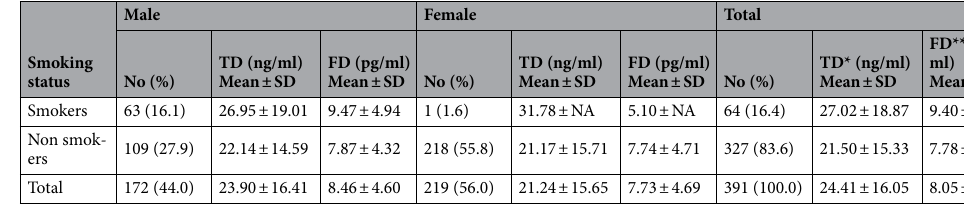
Table 7. Mean and standard deviation of Total 25-OHD and F25-OHD in respect to smoking. * P -value = 0.099, ** P -value = 0.656, NA Not applicable.